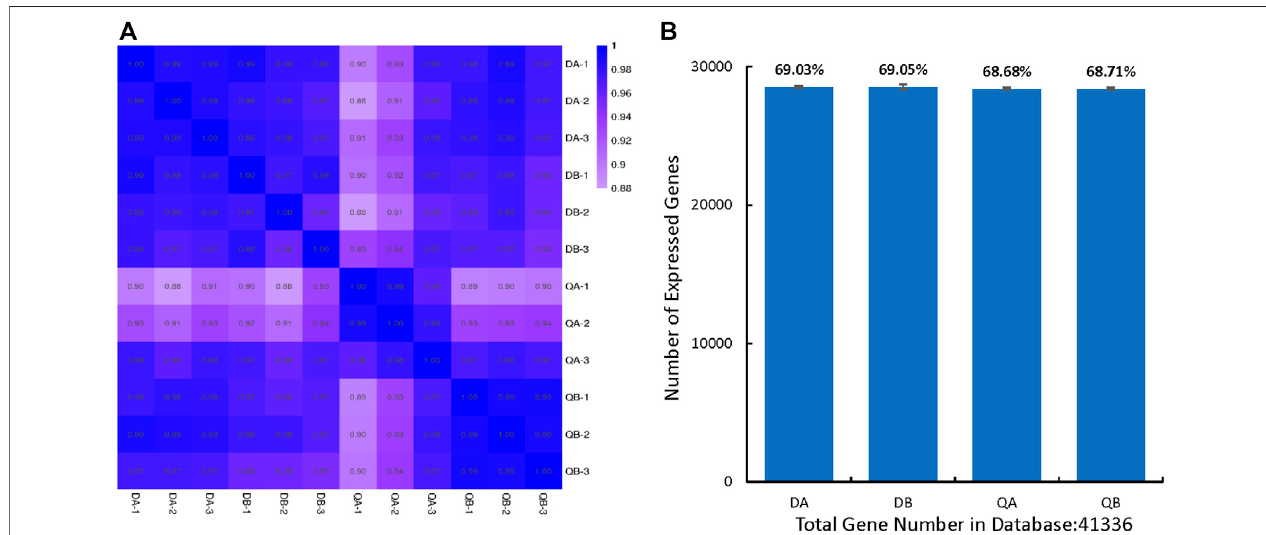
FIGURE1| Overviewoftransgenicandnon-transgenicpoplars ’ transcriptomes. (A) Pairwisecorrelationofdifferentbiologicalreplicatesfromoftransgenic(ABJ01) and non-transgenic (9#) using FPKM values. The color intensities (scale in the right side bar) and the numbers indicate the degree of pairwise correlation. (B) Number of expressedgenesinDatabaseofeachline,Theproportionatthetopofeachbarequalsexpressedgenesnumberdividedbytotalgenenumberreportedindatabase.DA: ABJ01 from Daqing, DB: 9# from Daqing; QA: ABJ01 from Qiqihar, QB: 9 # from Qiqihar.